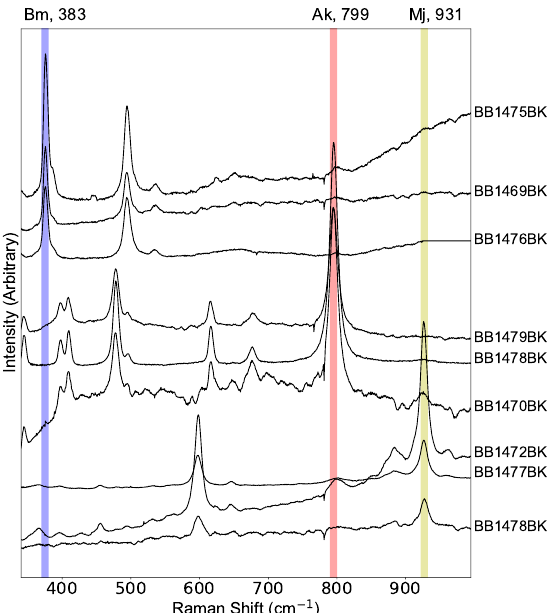
Figure 1. Raman spectra of the samples recovered from the Large-Volume Press (LVP) runs: The vertical lines highlight the key peaks for the identification of Bm (blue) at 383 cm − 1 , Ak (red) at 799 cm − 1 , and Mj (yellow) at 931 cm − 1 . An LVP run ID is provided to each spectrum (Table